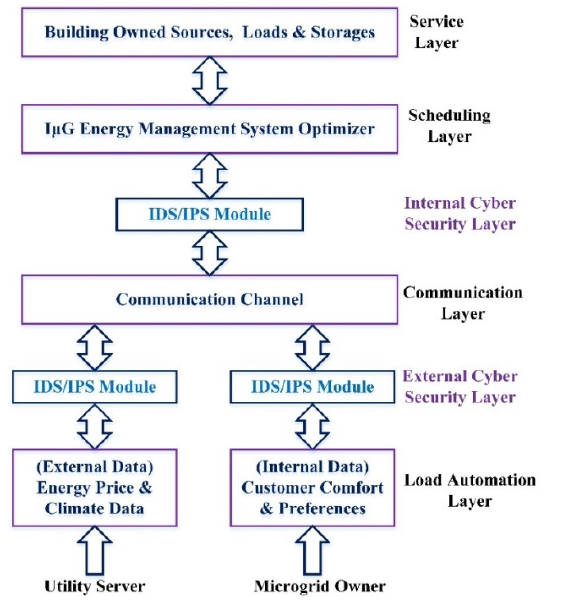
Fig. 1: Proposed Two-Cored Layered Process of BEMS for I μ G